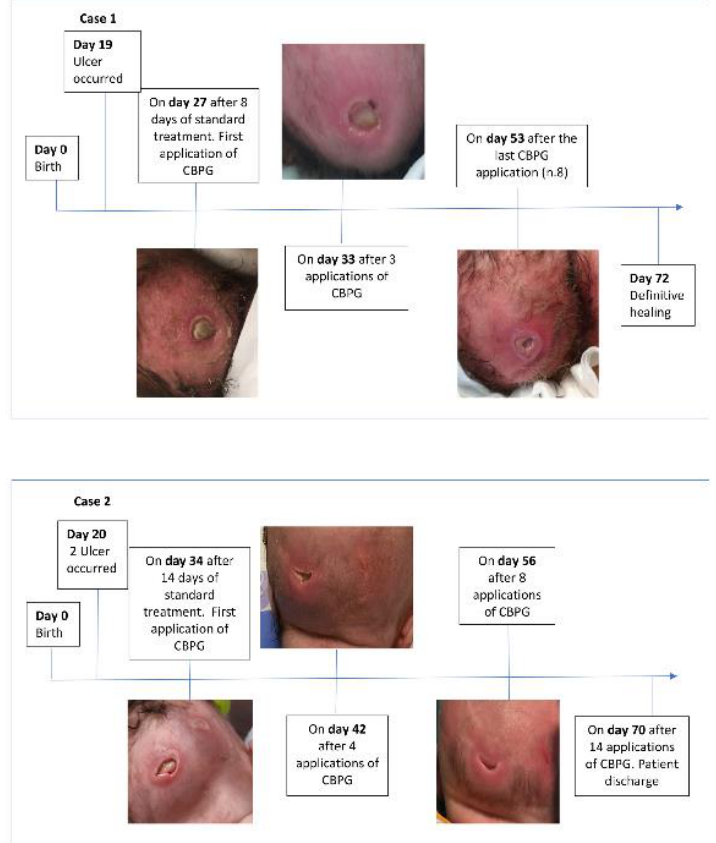
Figure 1. Case 1 and Case 2 timeline: from the development of PU to the definitive healing.